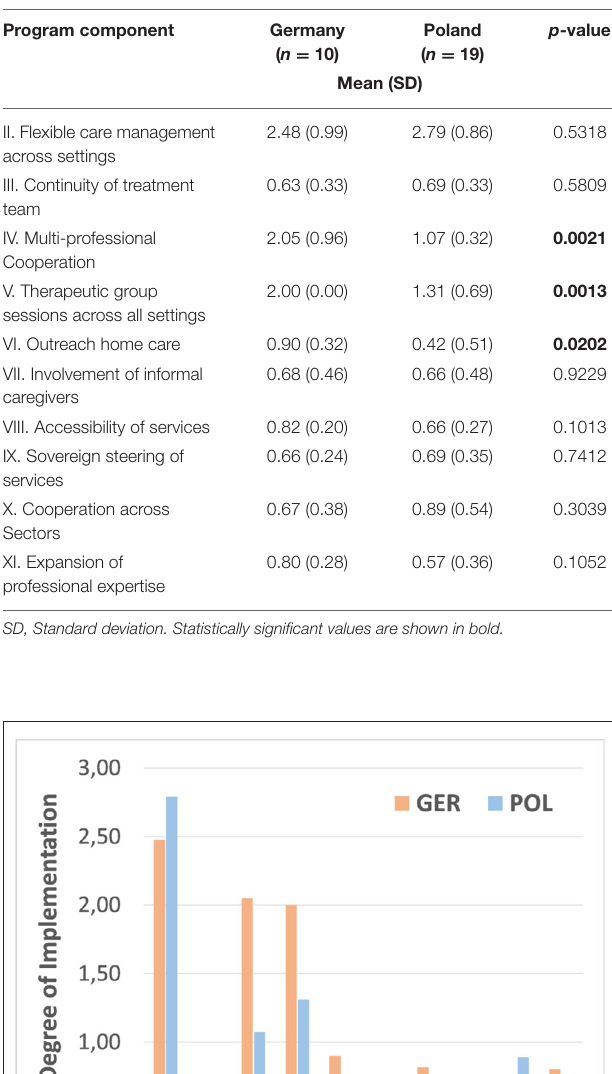
TABLE 4 | Average rating of the FIT-specific program components in comparison between German and Polish model